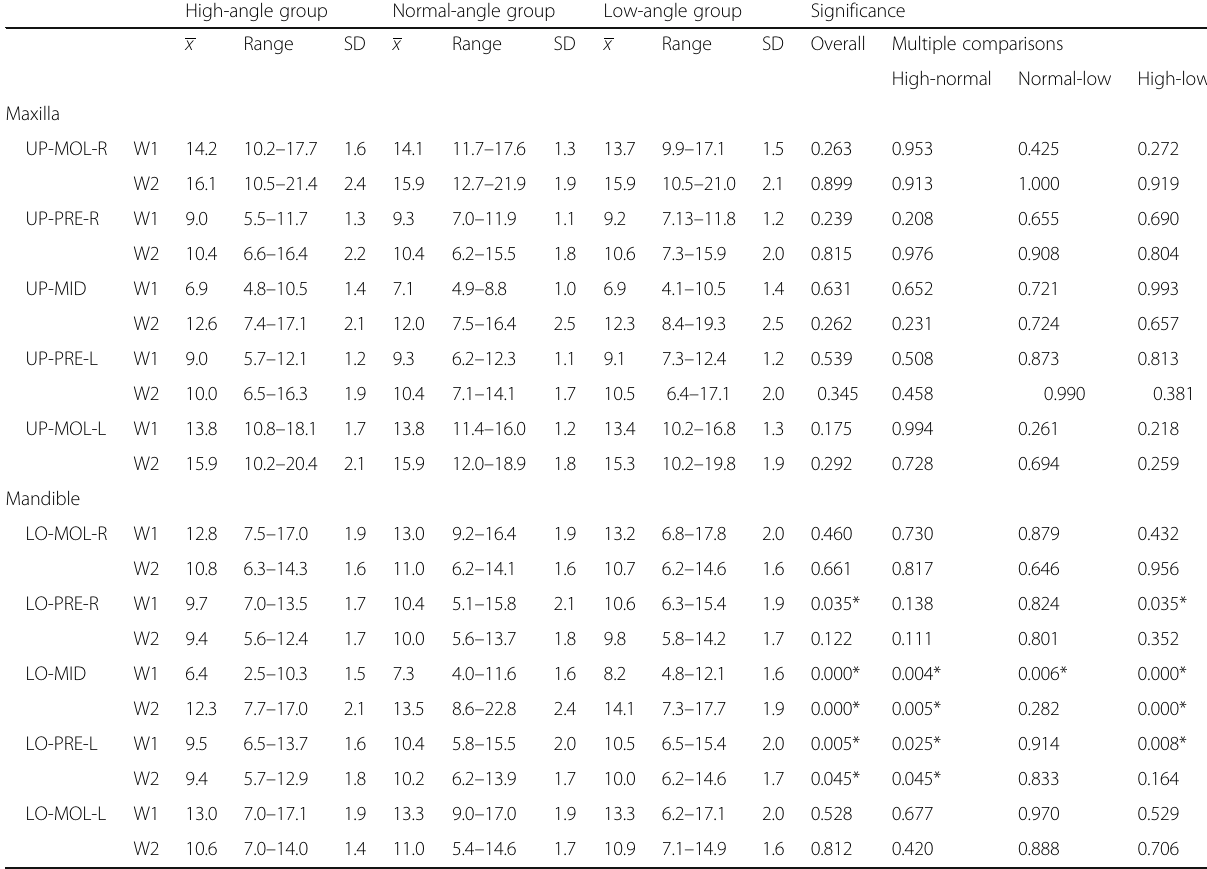
Table 2 Bone width in millimeters of the maxillary and mandibular